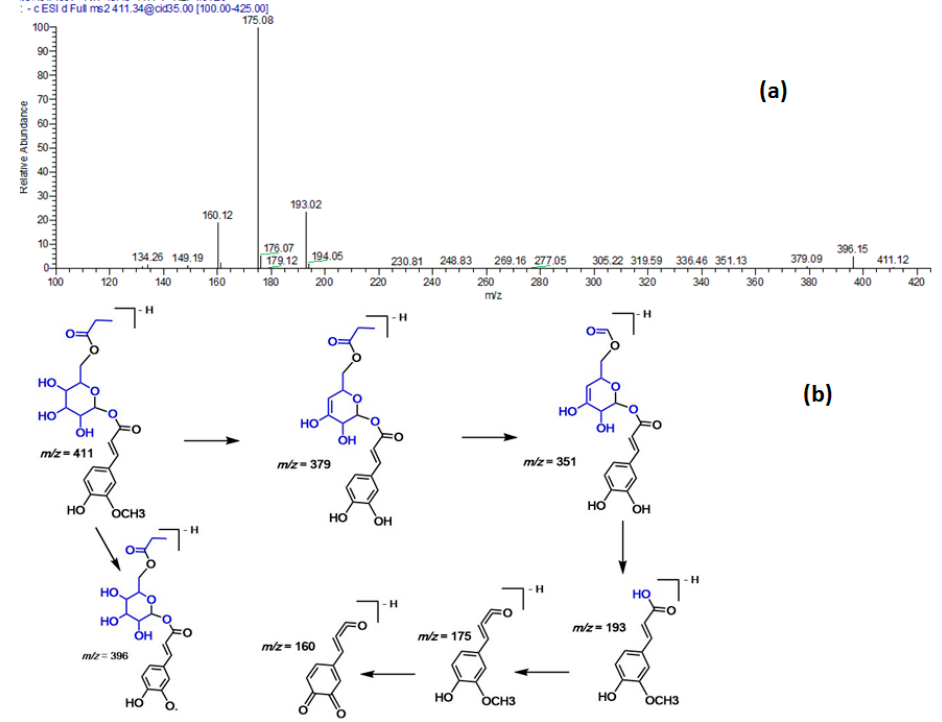
Figure 3. ( a ) MS/MS spectra of ferulic acid propionyl-glucoside at [M – H] − m/z 411. ( b ) A postulated fragmentation pattern in the negative ion mode.